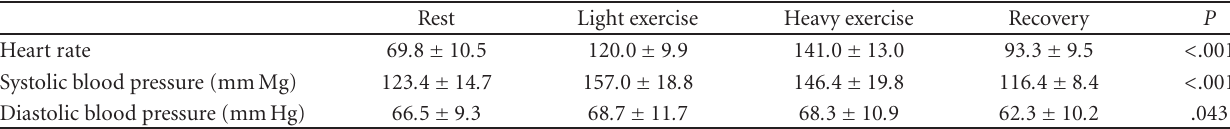
Table 1: Subject demographics and hemodynamic variables.